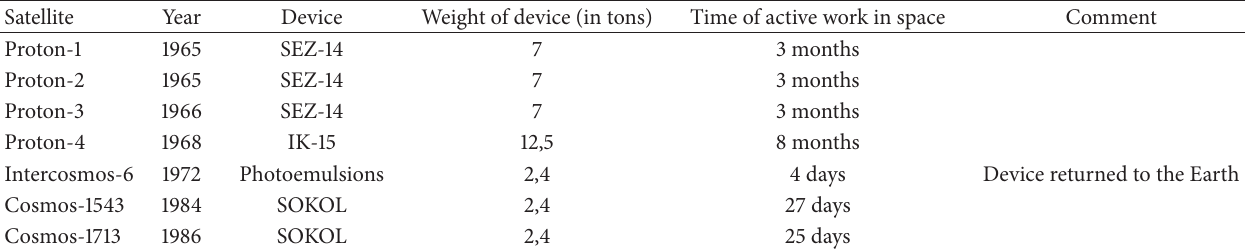
Table 1: Earth orbiting satellites with measurements of high-energy cosmic